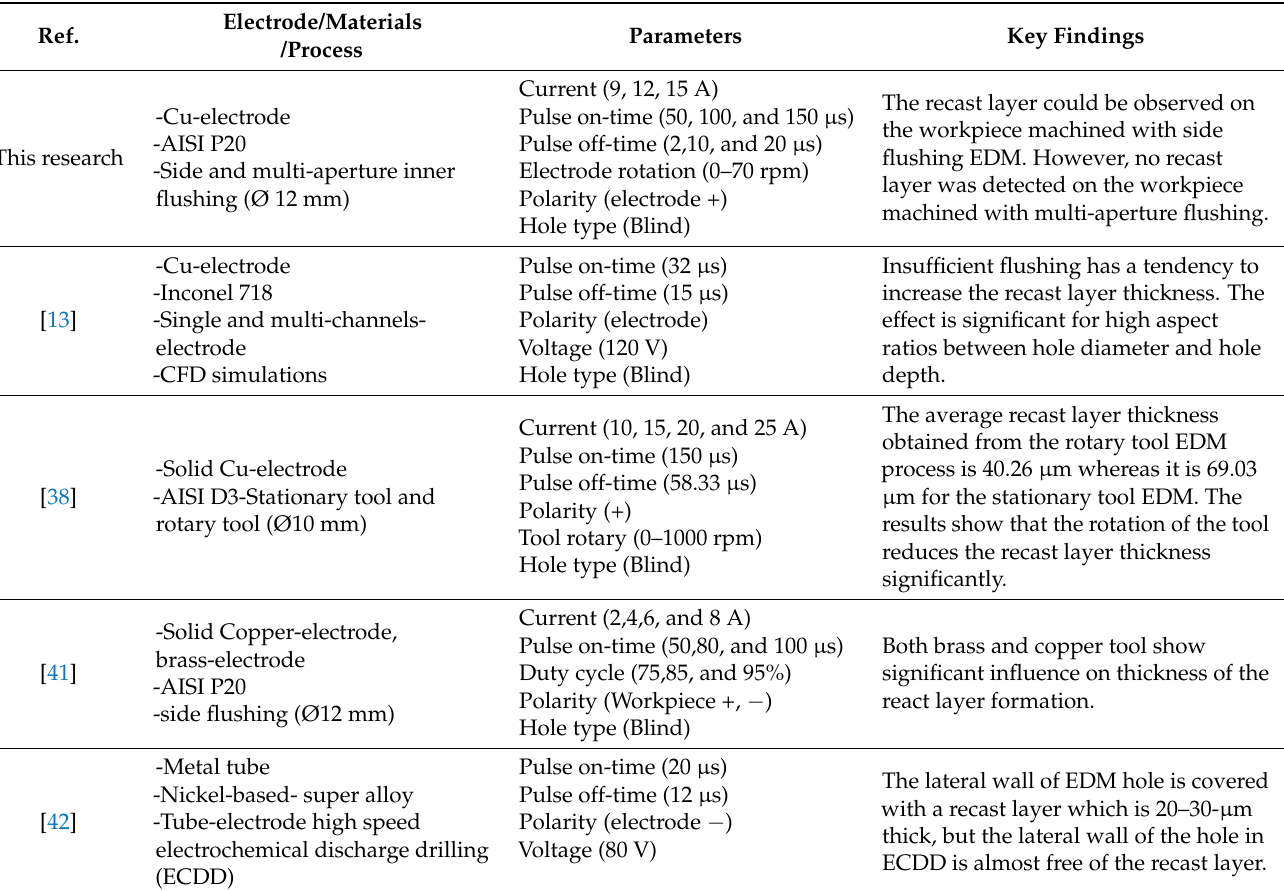
Table 15. Comparison of the machining characteristics on the recast